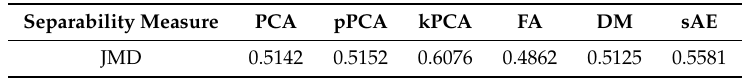
Table 3. Jeffries–Matusita Distance (JMD) scores showing separation across different dimensionality reduction